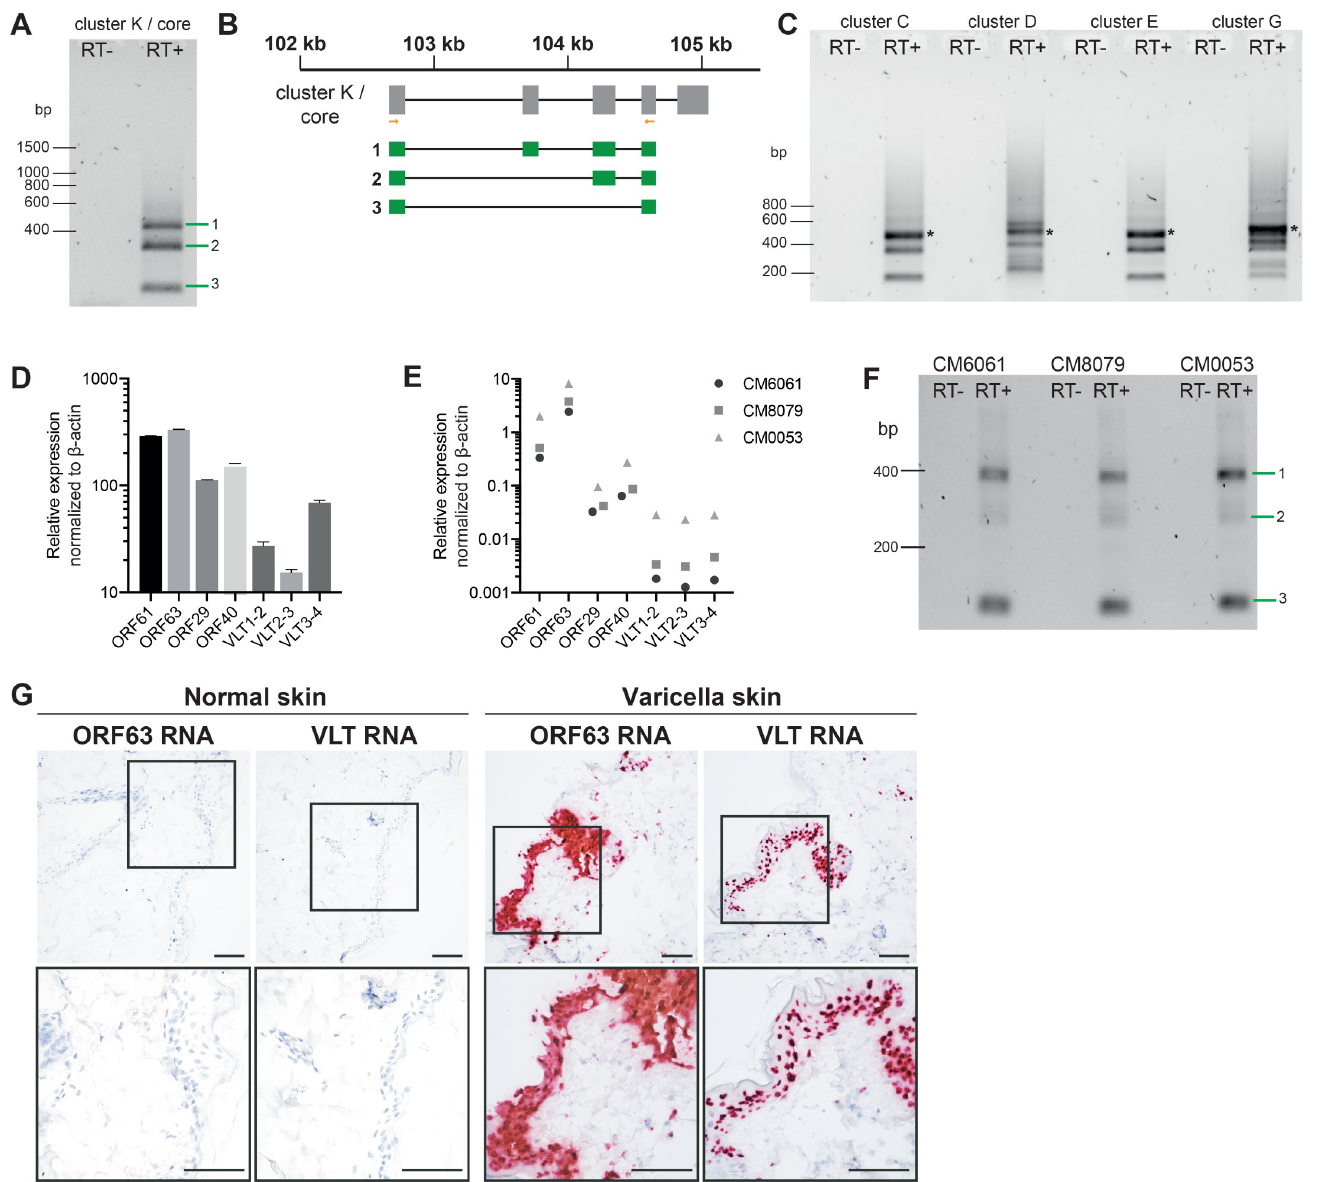
Fig 7. Confirmation of SVV VLT expression during lytic infection in vitro and in vivo . (A) RT-PCR confirmation of the core of SVV VLT indicates 3 major isoforms in BS-C-1 cells. (B) Diagram showing sequence confirmed SVV VLT isoforms. Grey boxes indicate core VLT according to dRNA seq, orange bars primer locations, and green boxes sequences obtained from indicated bands. (C) RT-PCR confirmation of 4 upstream exons represented by cluster C, D, E and G (see Fig 6) in BS-C-1 cells. Most abundant bands ( � ) were confirmed by sequencing. (D-E) RT-qPCR was performed on RNA extracted from SVV-infected BS-C-1 cells at 96 hpi (n = 2, mean ± SEM) (D) and lung tissue from n = 3 CM at 3 days post-infection (E). (F) RT-PCR and sequencing confirm presence of multiple isoforms during in vivo lytic infection, major bands confirm core exons and isoforms corresponding to B. (G) Detection of VLT and ORF63 RNA (red signal) by in situ hybridization in consecutive sections of normal and varicella skin lesions of an SVV-infected AGM at 9 dpi. Sections were counterstained with hematoxylin. Scale bars indicates 50 μ m. Representative images are shown for AGM